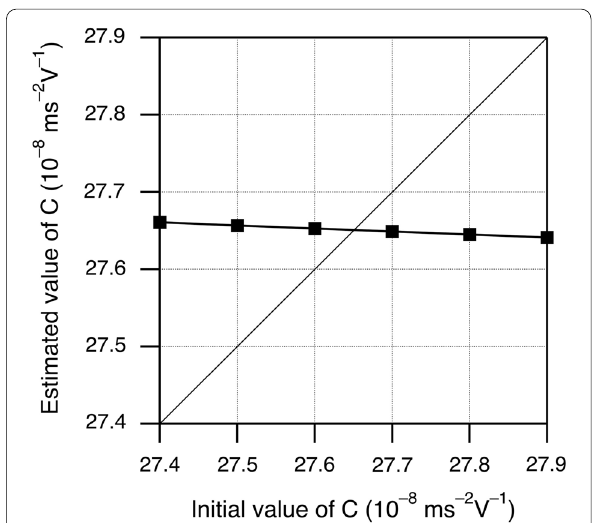
Fig. 5 Determination of the parameter C (see Eq. (45)) by an iterative estimation